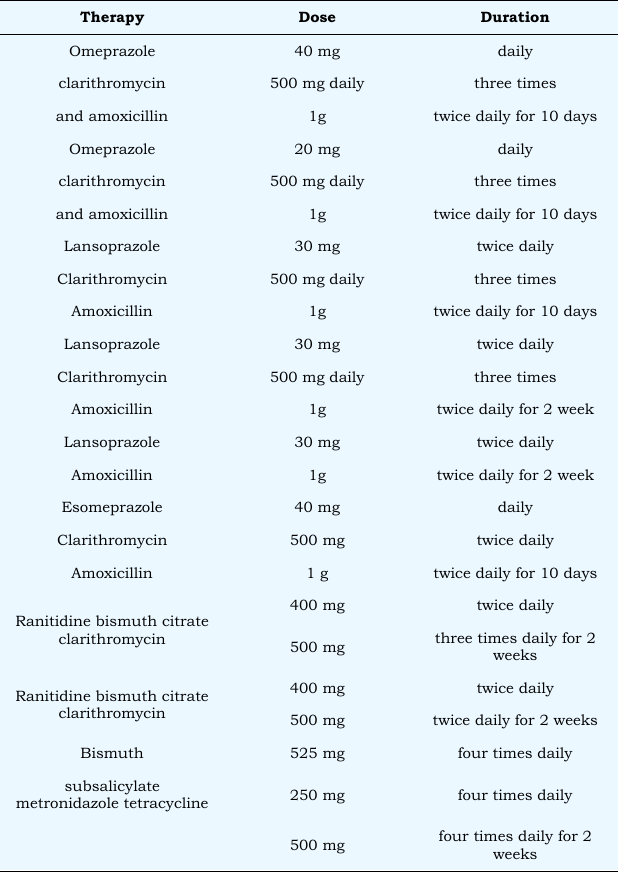
Table 1 Food and Drug Admostration - Approved treatment option for H. pylori eradication (Sebastian, and Pierre, 2002) Therapy Dose Duration Omeprazole 40 mg daily clarithromycin 500 mg daily three times and